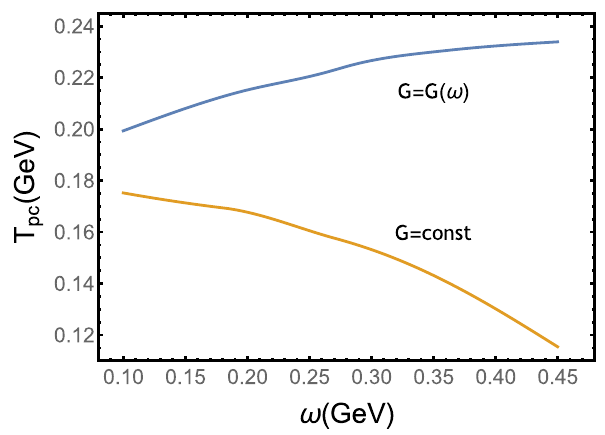
Fig. 4 Pseudo critical temperature as function of ω by choosing 4- fermion coupling G as G (ω) in Eq. 18 and a constant, i.e. G = 4 . 93 GeV − 2 as the usual NJL